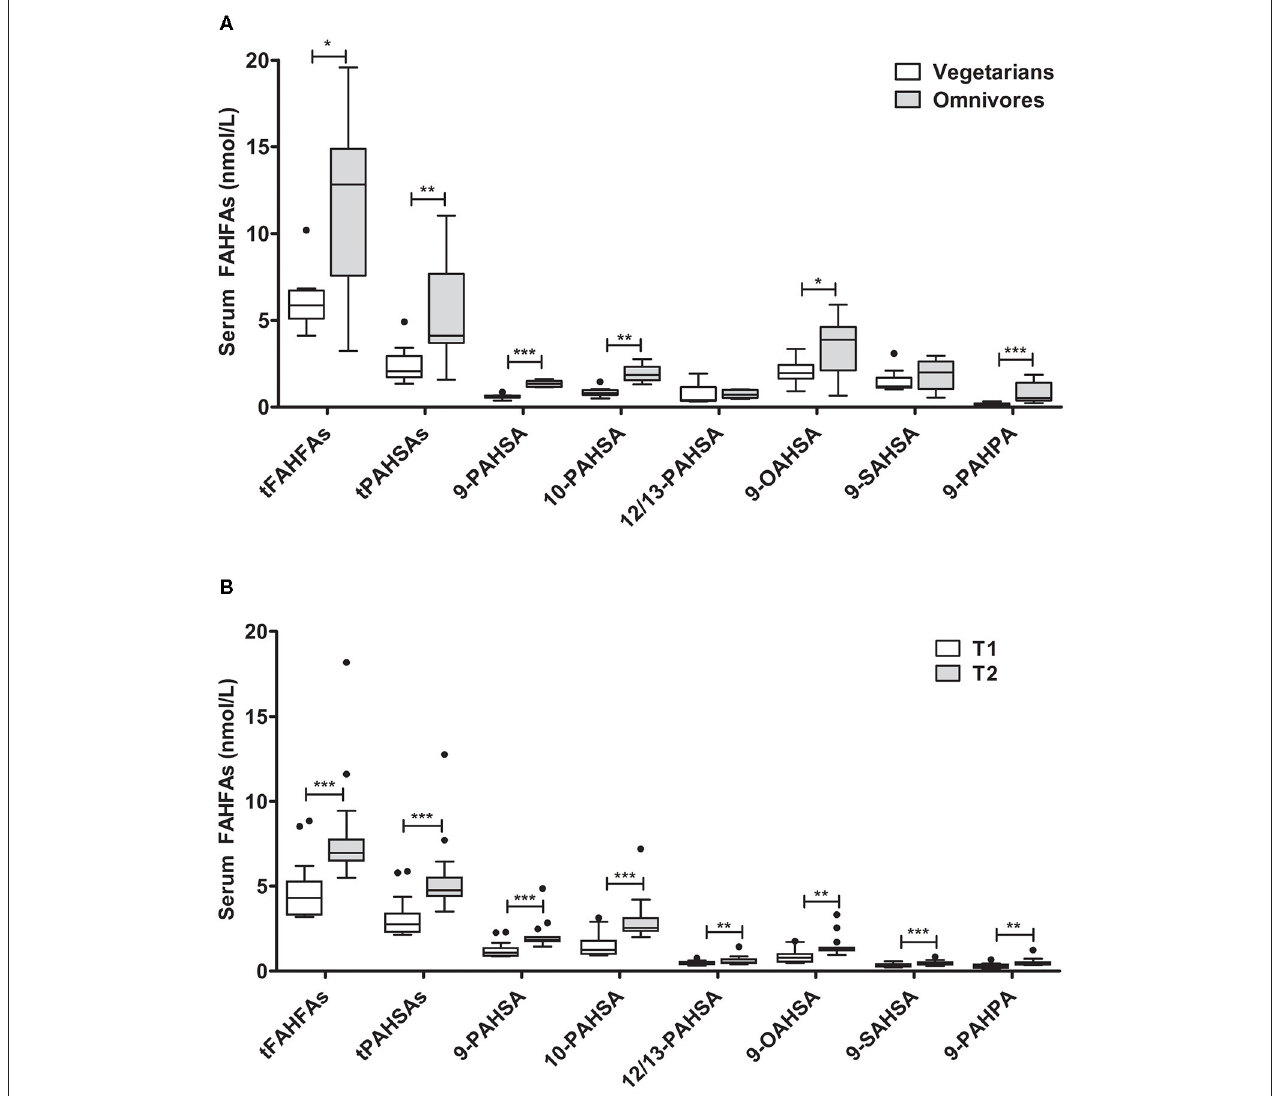
FIGURE 4 | FAHFA concentrations in vegetarians/vegans compared to omnivores and in lean young men before and after acute overfeeding. (A) FAHFA concentration in individuals following a vegetarian or vegan diet (vegetarians) in comparison to individuals under a normal diet (omnivores). Mann-Whitney test was used to compare the groups. n = 10/9 (vegetarians/omnivores), except for 9-, 10- and 12/13-PAHSA: n = 10/5. (B) FAHFA concentration in young, healthy males undergoing short-term overfeeding. Wilcoxon matched-pairs test was used to compare participants before (T1) and after (T2) intervention. Box plots describe the median and the 25th percentile and 75th percentile. n = 15. * P < 0.05; ** P < 0.01; *** P < 0.001. t, total (sum of FAHFAs/PAHSAs measured); FAHFA, fatty acid ester of hydroxy fatty acid; OAHSA, oleic acid-hydroxy stearic acid; PAHPA, palmitic acid-hydroxy palmitic acid; PAHSA, palmitic acid-hydroxy stearic acid; SAHSA, stearic acid-hydroxy stearic